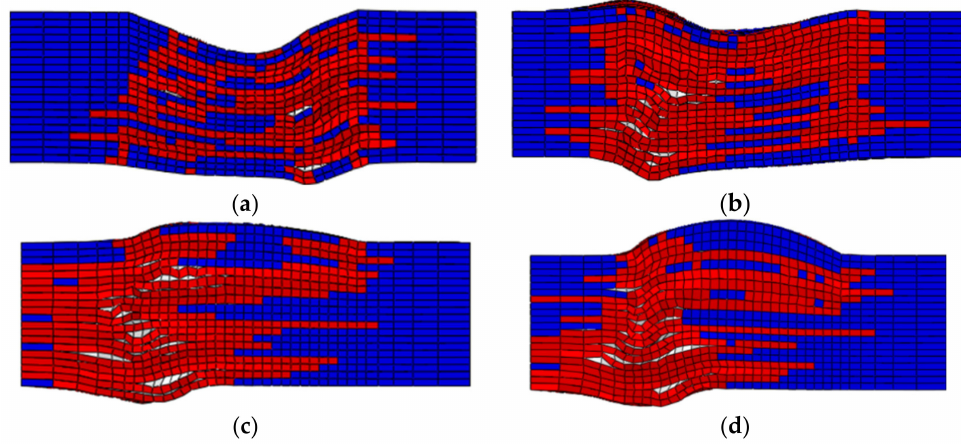
Figure 12. Simulation failure modes with different A / H : ( a ) − 20%, ( b ) − 10%, ( c ) 10%, ( d )